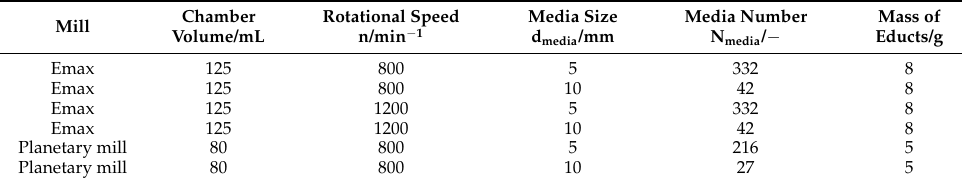
Table 4. Operation parameters for the comparison of Emax and planetary